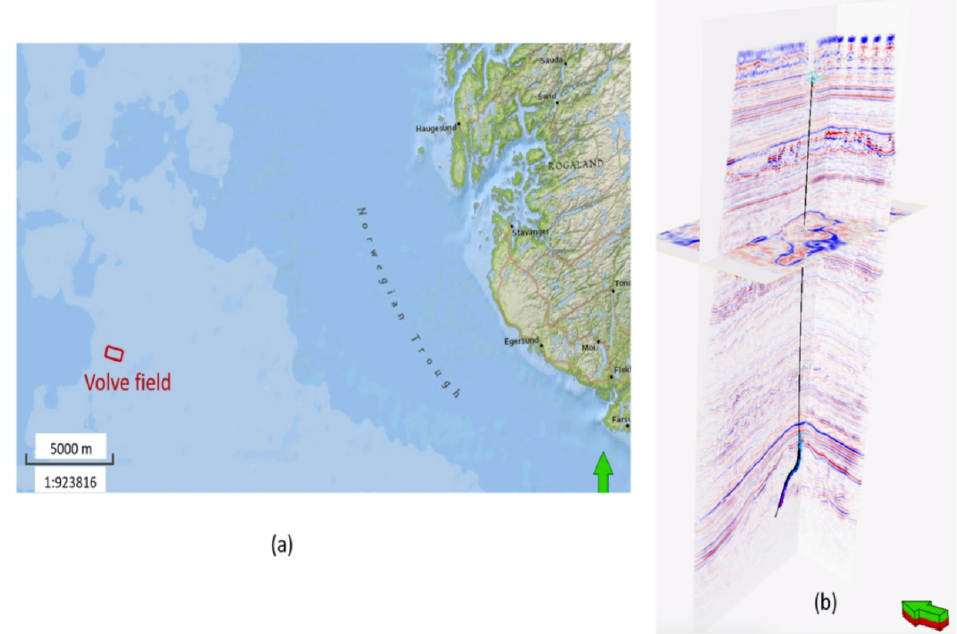
Figure 9. ( a ) Volve field shown in map located in offshore North Sea, ( b ) Seismic data along with a well trajectory from the Volve field (Figures are from [25]).